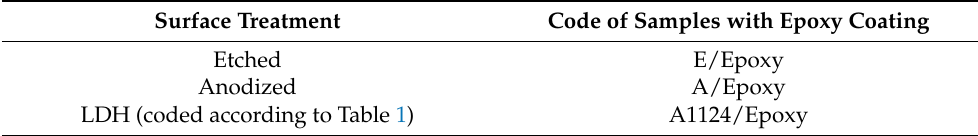
Table 2. codes used for samples with epoxy coating.